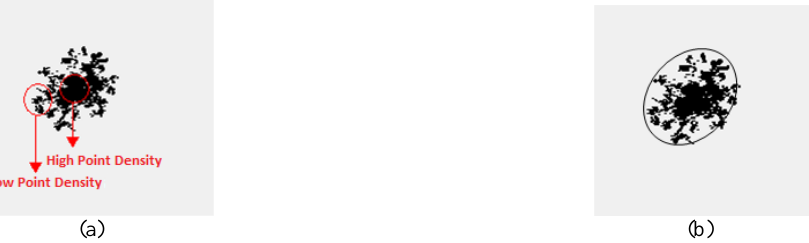
Figure 1. Two-dimensional point set: (a) Point density in center and surroundings; (b) Outline of the two-dimensional point set